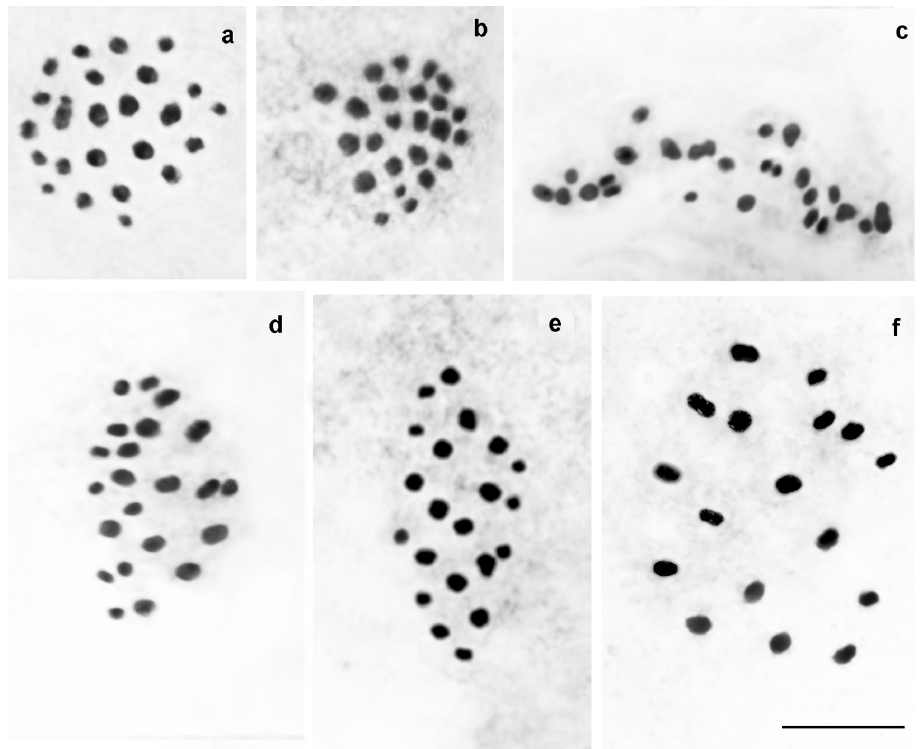
Figure 7. Karyotypes of P. zarathustra , P. arasbarani , P. lukhtanovi and P. shamil. a P. zarathustra , sample Z401, MI, n=24 b P. arasbarani arasbarani , sample N98, MI, n=24 c P. arasbarani neglectus, sample Q457, MI, n=ca25-26 d P. lukhtanovi , sample F875, MI, n=22 e P. lukhtanovi , sample H717, MI, n=21 f P. shamil , sample F958, MI, n=17. Bar = 10